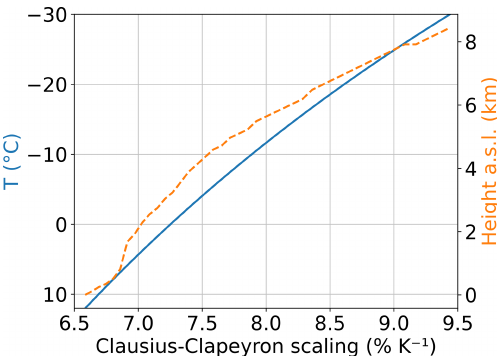
Figure 1. Clausius–Clapeyron scaling dlog( e sat ) / d T as a function of temperature (solid blue) and as function of height above sea level (a.s.l.; dashed orange) in the study region for the simulated